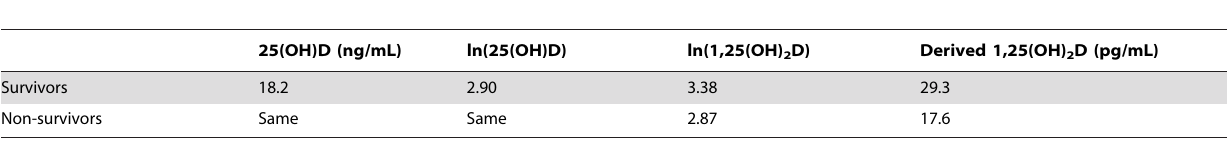
Table 4. Lower 1,25-dihydroxyvitamin D (1,25(OH) 2 D) production in non-survivors for the same level of substrate 25- hydroxyvitamin D (25(OH)D) as in